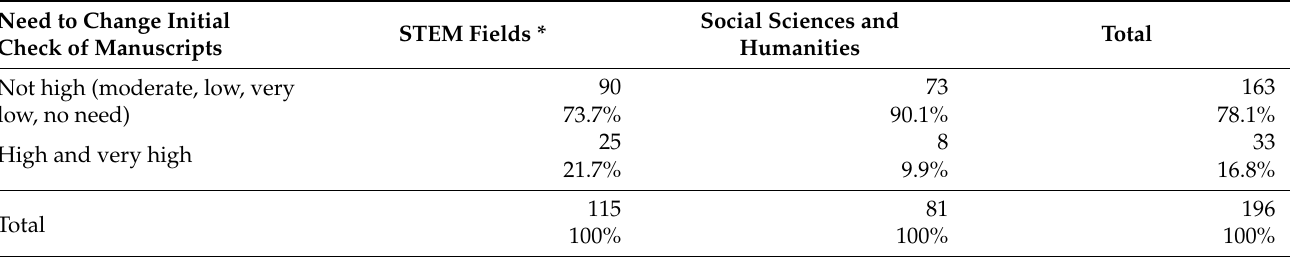
Table 9. Association between journal’s scientific field and respondents’ estimation of need to change initial check of manuscripts.